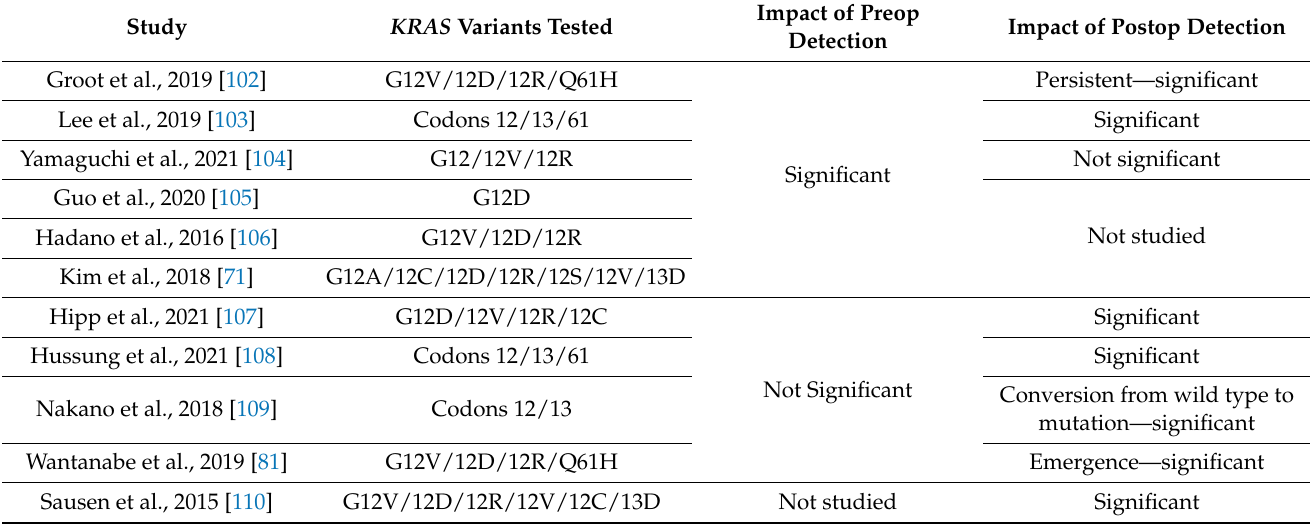
Table 4. Preoperative risk stratification of pancreatic ductal